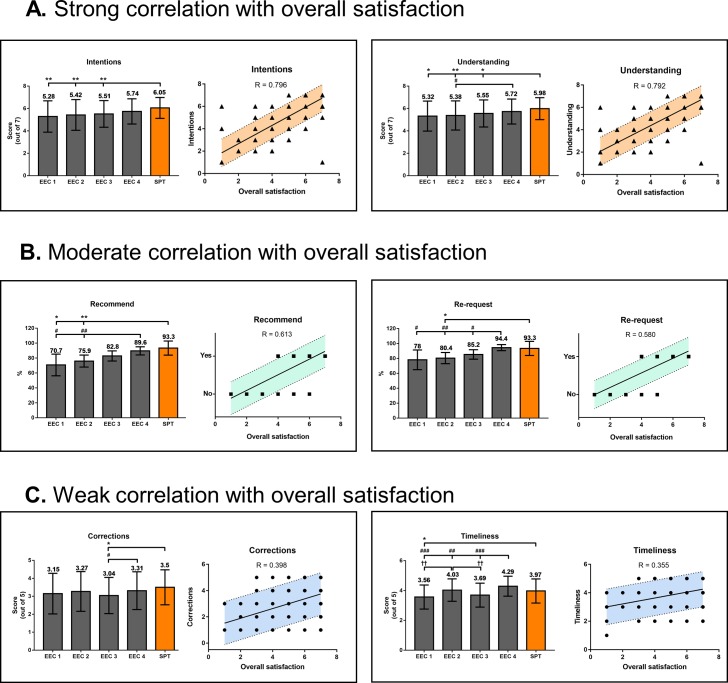
Specific question scores.Scores of specific questions (items #2 –#7 in Table 1) from blind survey results. Questions that showed (A) strong, (B) moderate, and (C) weak correlation with overall satisfaction score. Column bar graphs show the mean scores of each question (numbers on top of the bars); error bars indicate 95% confidence range in “Re-request” and “Recommend,” and standard deviation from mean in others. Scatter plots show the correlations between overall satisfaction and the specific questions. Trend between two variables are indicated by the solid lines. Shaded areas between dotted lines indicate 95% confidence range. * P < 0.05 vs. SPT, # P < 0.05 vs. EEC 4; **, ##, †† P < 0.01 vs. SPT, EEC 4, and EEC 2, respectively; ##, P < 0.001 vs. EEC 4; **** P < 0.0001 vs. SPT.